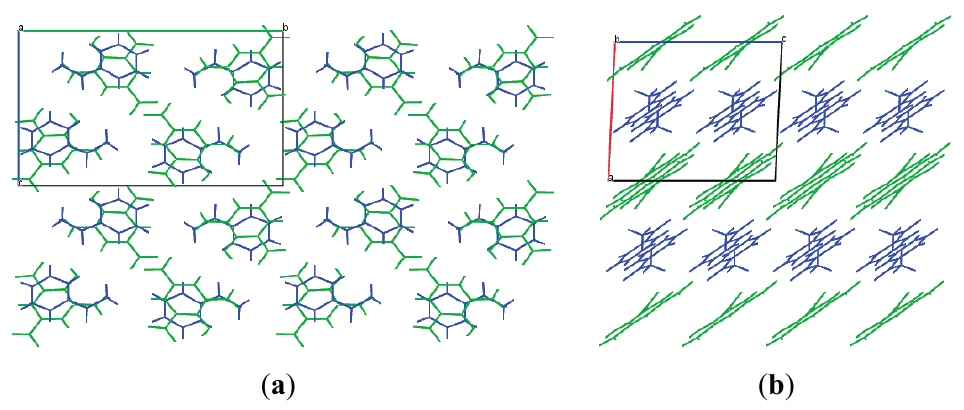
Figure 2. Cocrystal packing diagram viewed along the a-axis ( a ) and b-axis ( b ).